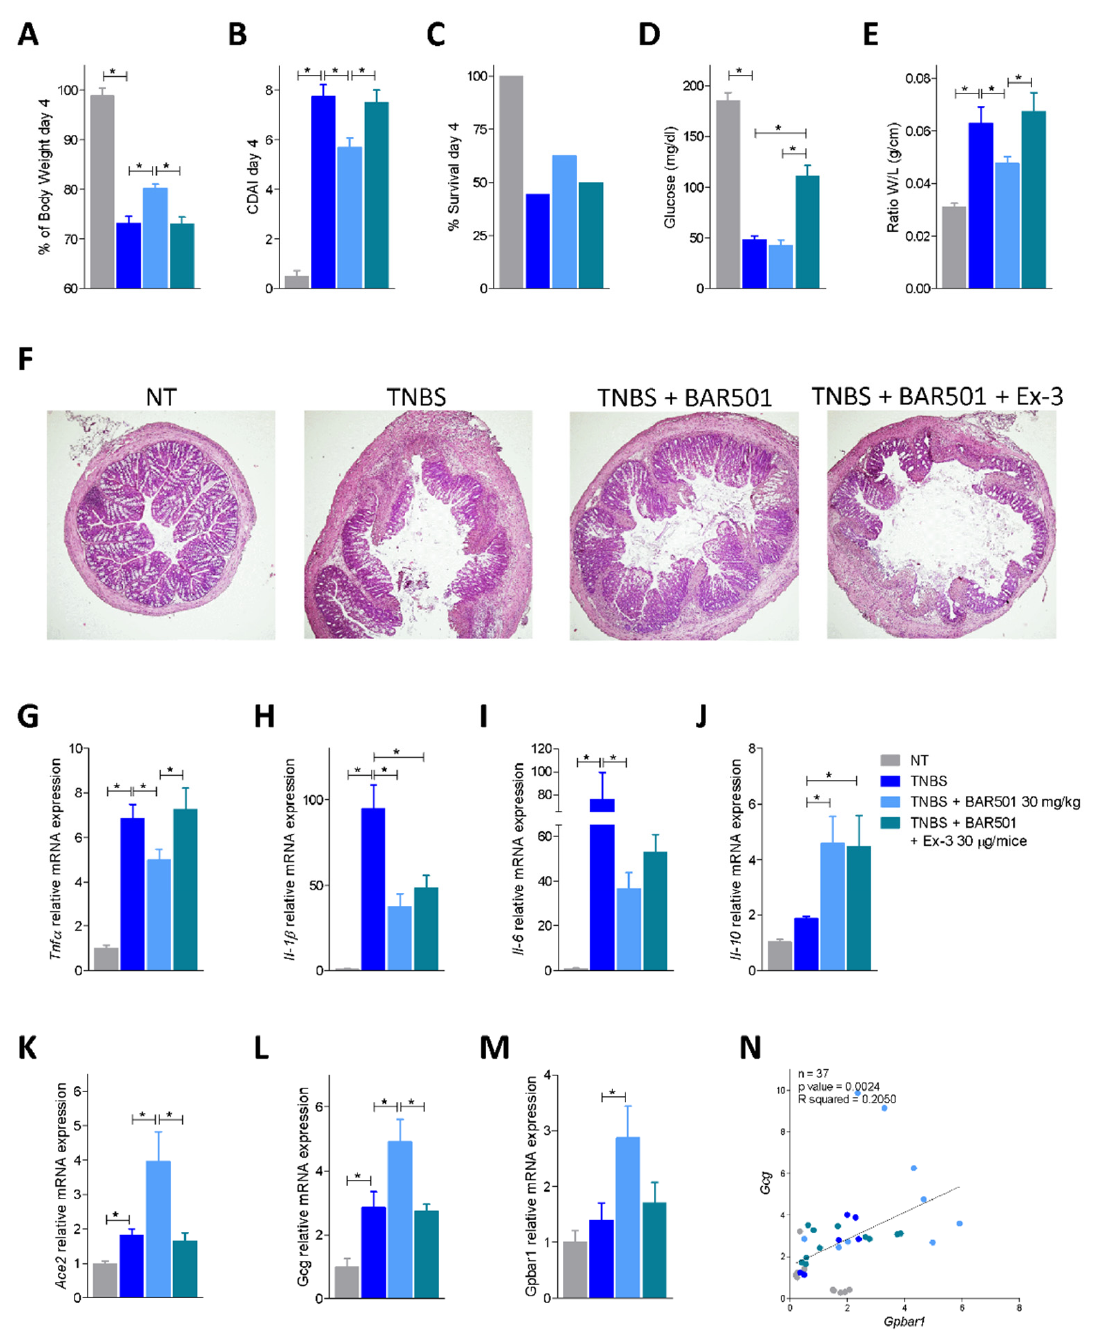
Figure 6. Bar501-dependent Ace2 upregulation effect was suppressed by co-administration of Bar501 and Ex-3 in a Gpbar1/Gpl-1/Glp-1R axis-dependent manner. Bar501 (30 mg/Kg) or a combination of BAR501 plus exendin-3 (Ex-3) (30 μ g/mice), a GLP-1R antagonist, were administrated in C57BL/6J male mice on day 0 of a colitis TNBS model, for an additional 3 days. The fourth day was